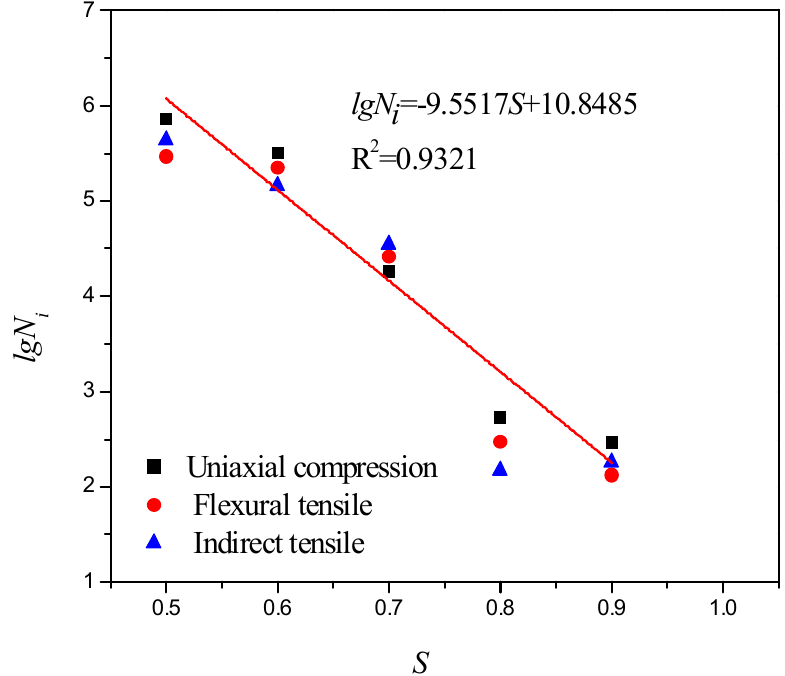
Figure 14. Standardization equations for fatigue properties with a cement content of 5% at a curing time of 90 days and a guaranteed rate of 95% under different stress states.